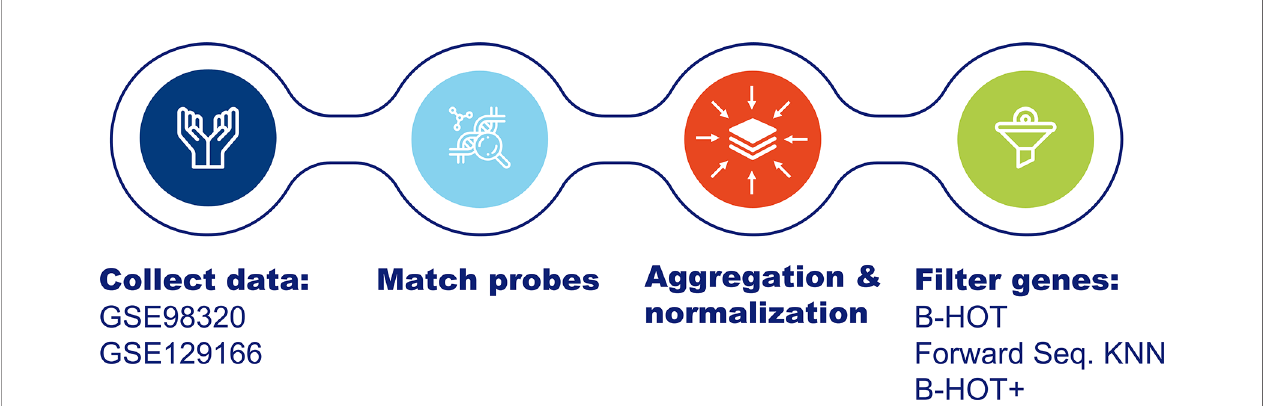
FIGURE 1 | Overview of Data Collection and Preprocessing. Data has been retrieved from the GEO dataset repository. Probes have been matched using raw annotation fi les and then aggregated based on the median values and using robustscale per feature. Finally, the genes from the Banff Human Organ Transplant B- HOT panel have been fi ltered. B-HOT, Banff-Human Organ Transplant; GEO, Gene Express Omnibus; KNN,